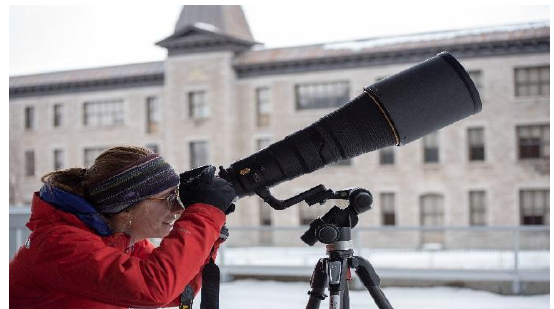
Figure 1: 600 mm lens used to capture high resolution imagery.